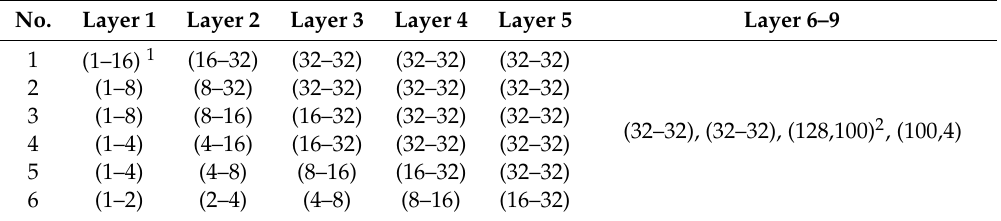
Table 1. Di ff erent structures of 6 CNN